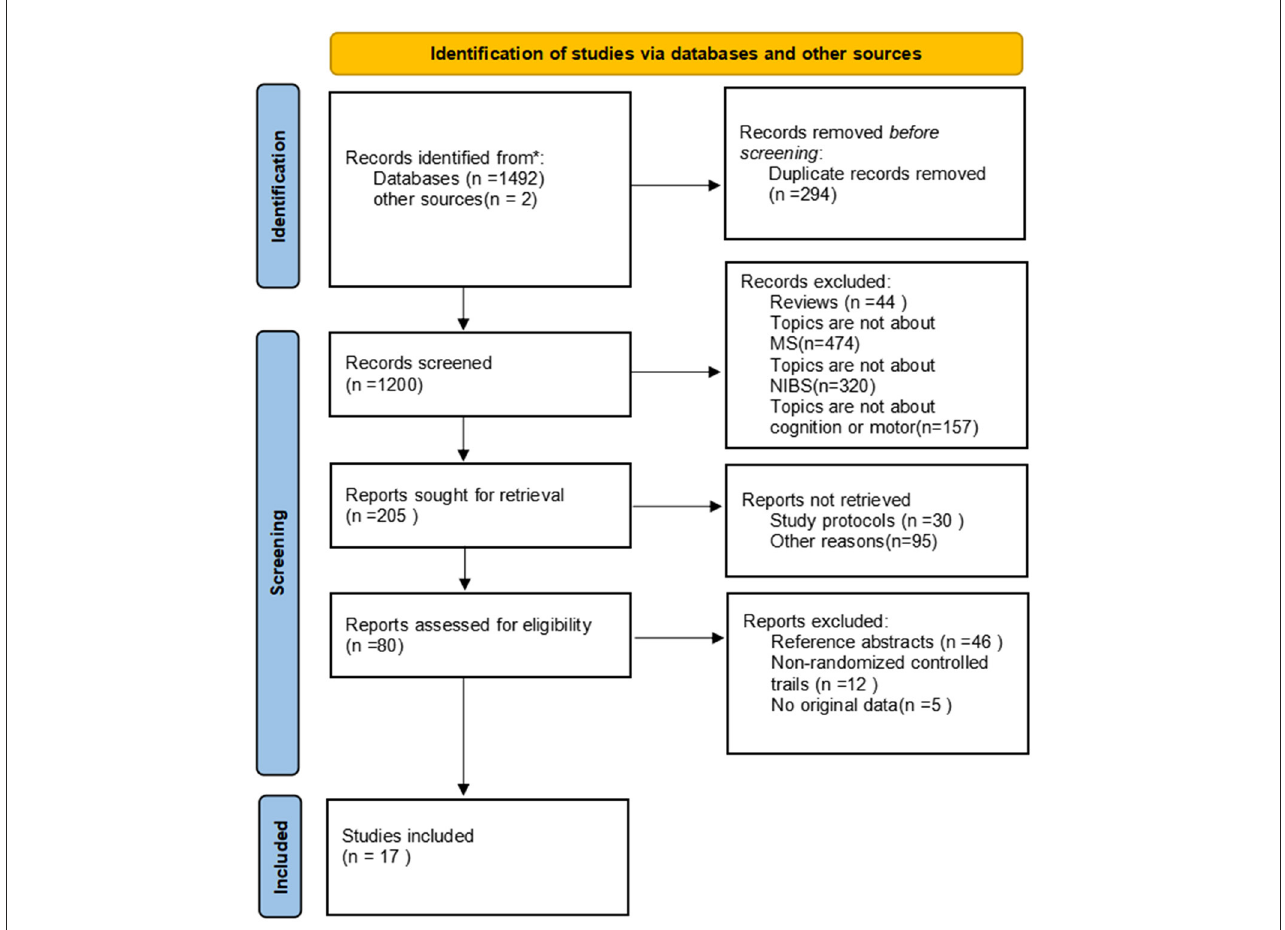
FIGURE1 Flow diagram of literature